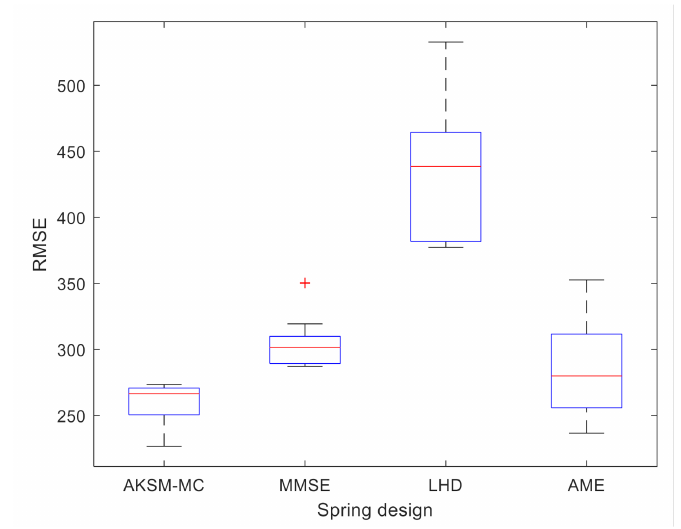
Figure 16. Box plot of the RMSE values of the four methods.